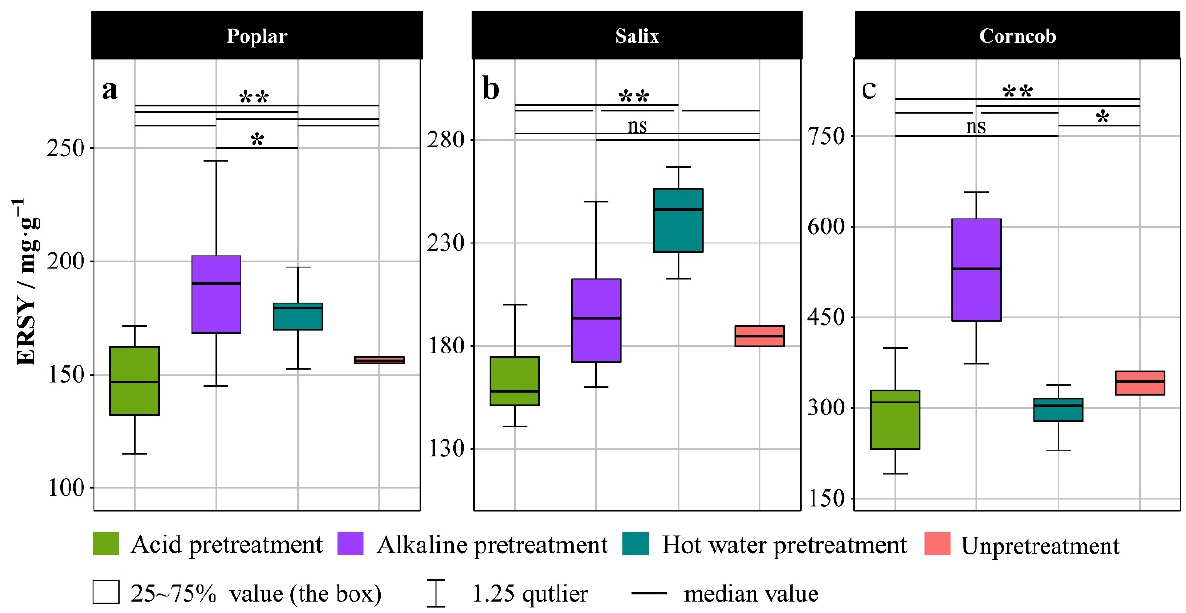
Figure 1. Distribution of enzymatic reducing sugar yield (ERSY) under different pretreatment methods. ( a ). Poplar. ( b ). Salix. ( c ). Corncob. All boxplot distributions are tested using Independent-Samples t-test at the 95% level compared with each other; *, p < 0.05; **, p < 0.01. Note: Each box represents a distribution of one pretreatment method containing a nine ‐ condition dataset.